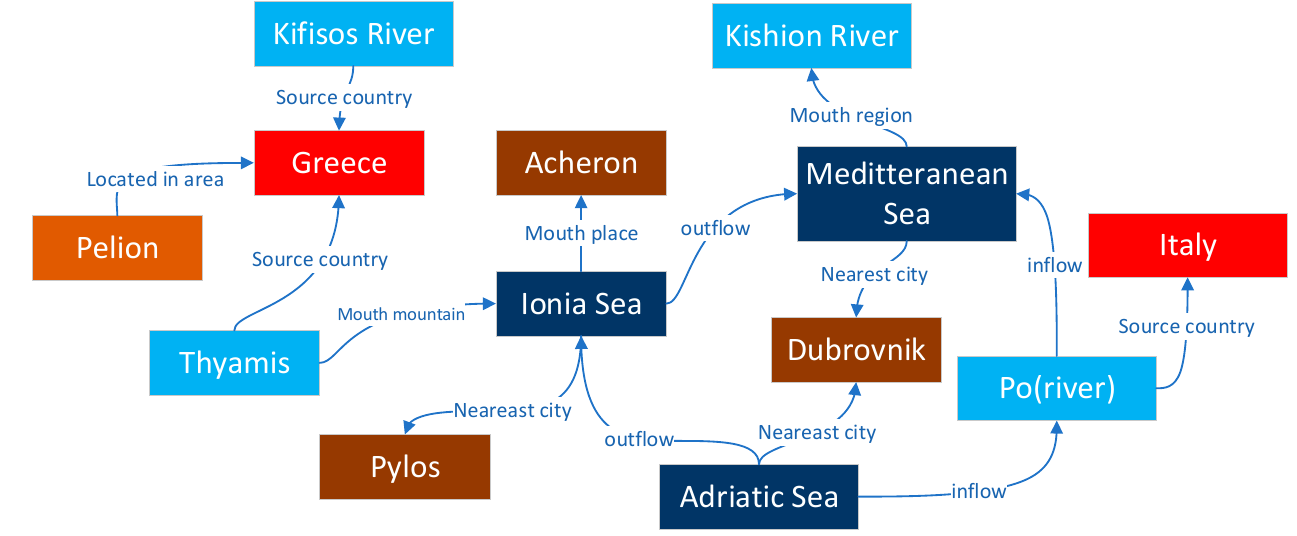
Figure 1. An example visualization of a GeoKG. The completion of geo-relations is realized by predicting the relation in GeoKG. for example, obtaining the value of “r” in the triplet <Ionian Sea, r, Meditteranean Sea> through relation prediction modeling, or predicting the value of “h” in <h, outflow, Meditteranean Sea> or the value of “t” in <Ionian Sea, outflow, t>. Existing relation prediction methods include inference methods based on deductive reasoning, inductive reasoning, and repre- sentation learning. Methods based on deductive reasoning [11] require clearly defined prior information, such as defining axiomatic rules of (province, contains, city) and (country, contains, province) then (province, contains, city), to complete the “contains” relation between the province and city category entities in a KG. This type of method has high accu- racy, but also high labor cost. Methods based on inductive reasoning [12] can effectively mine axiomatic rules with high confidence from large-scale KGs, which reduces the cost of manually defining rules, to a certain extent, and also eliminates potential subjective errors made by the rule makers. However, these two types of methods remain difficult to apply to the open GeoKGs that have a large scale of data and many types of relations. The reasoning method based on representation learning can map the entities and relations in a KG to the vector space, and transform the geo-relations prediction problem into the direct calculation between vectors, which makes it possible to complete more relations in a large-scale